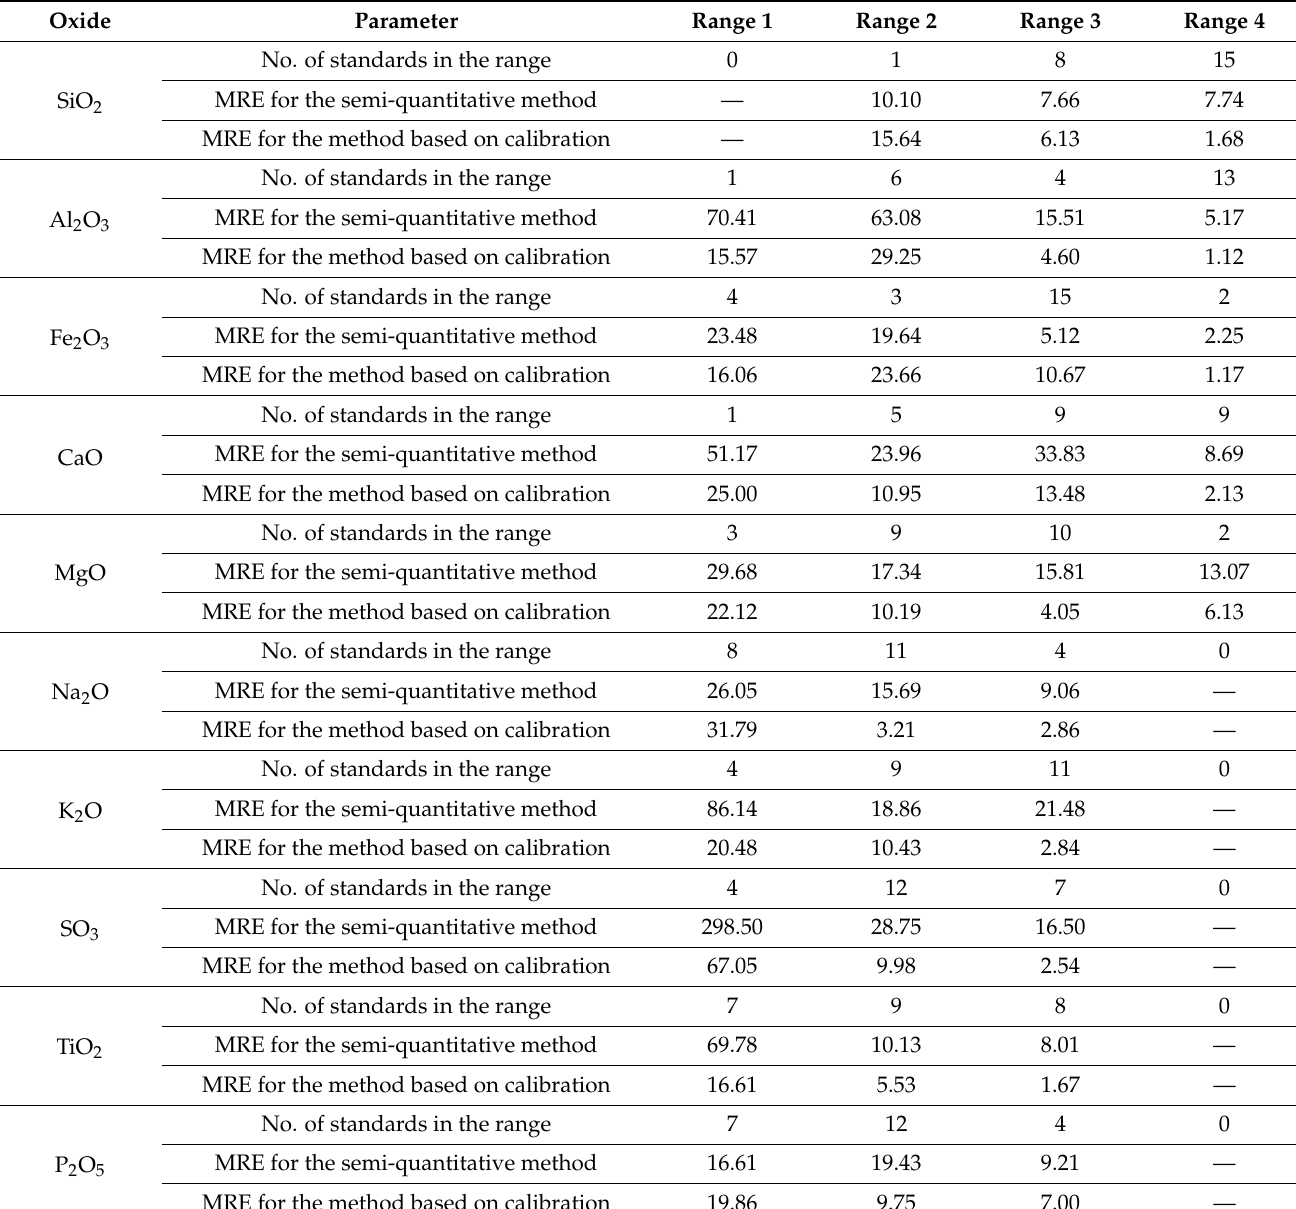
Table 10. The mean values of the relative errors (MRE) obtained for the semi-quantitative method and for the method based on calibration in the reference to the certified